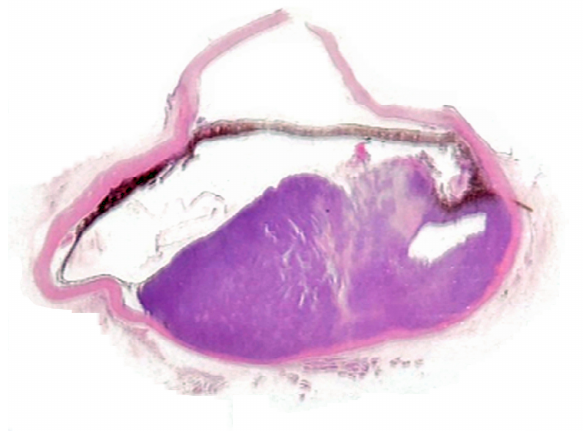
Figure 2. The left eye, where a large mass occupied approximately 70% of the posterior chamber.